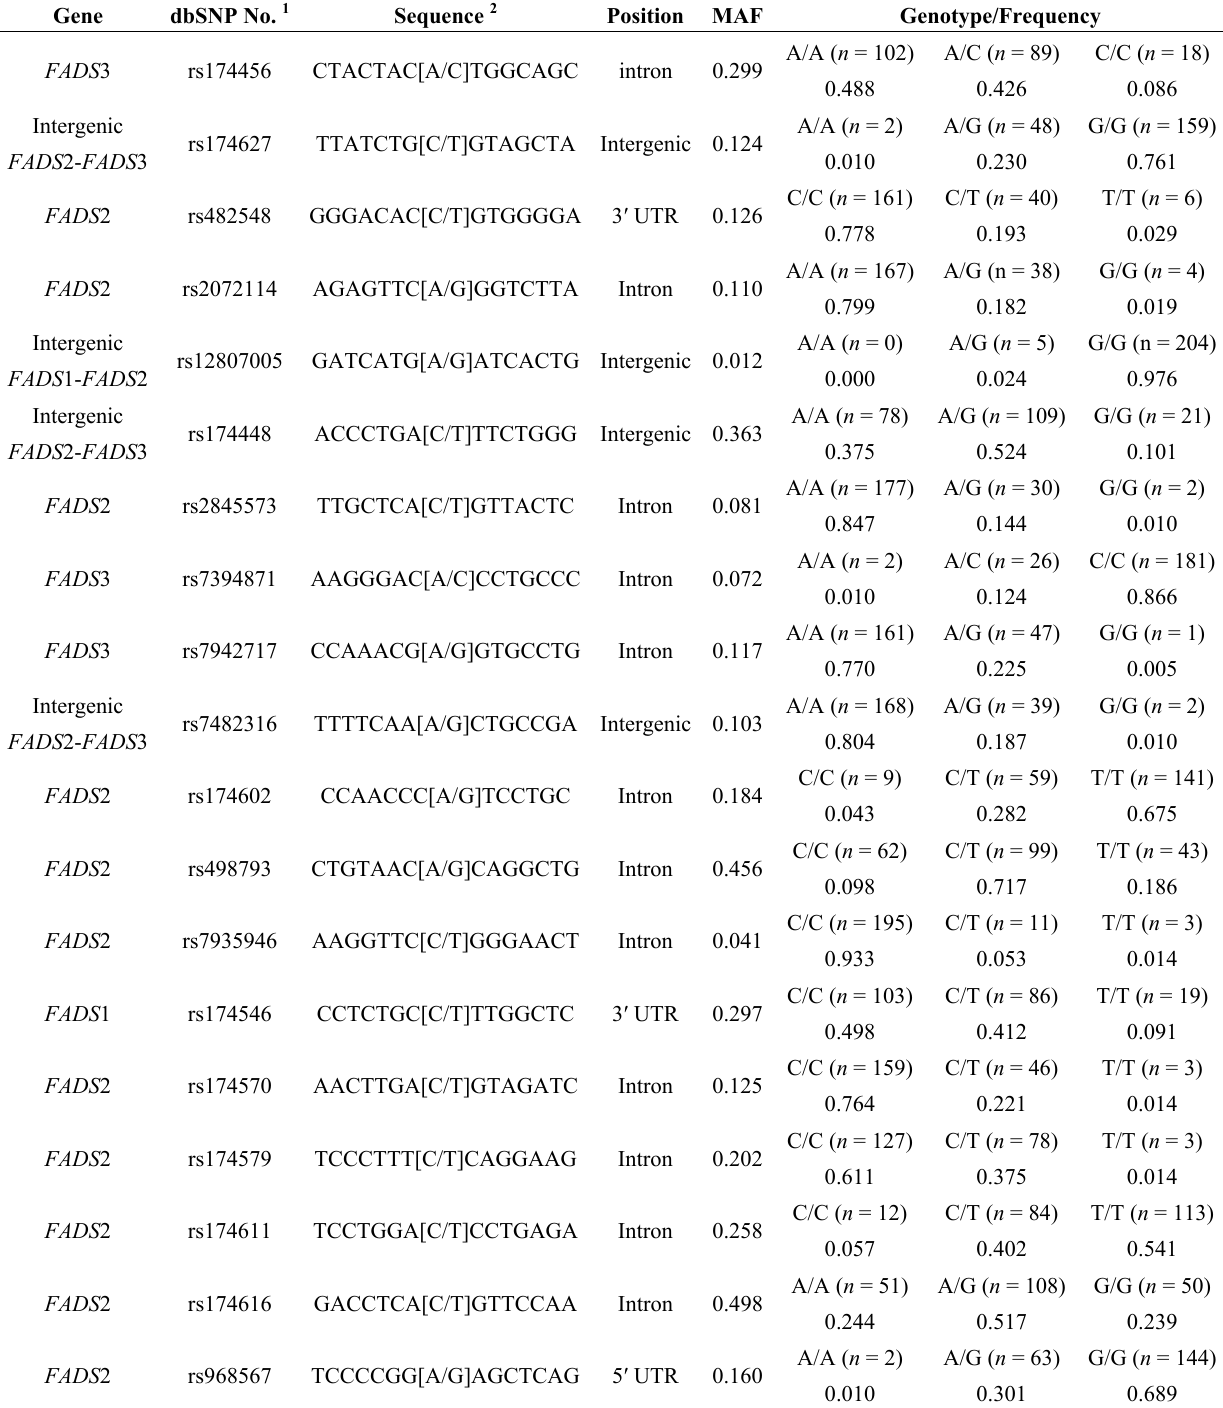
Table 1. Selected polymorphisms in the fatty acid desaturase ( FADS ) gene